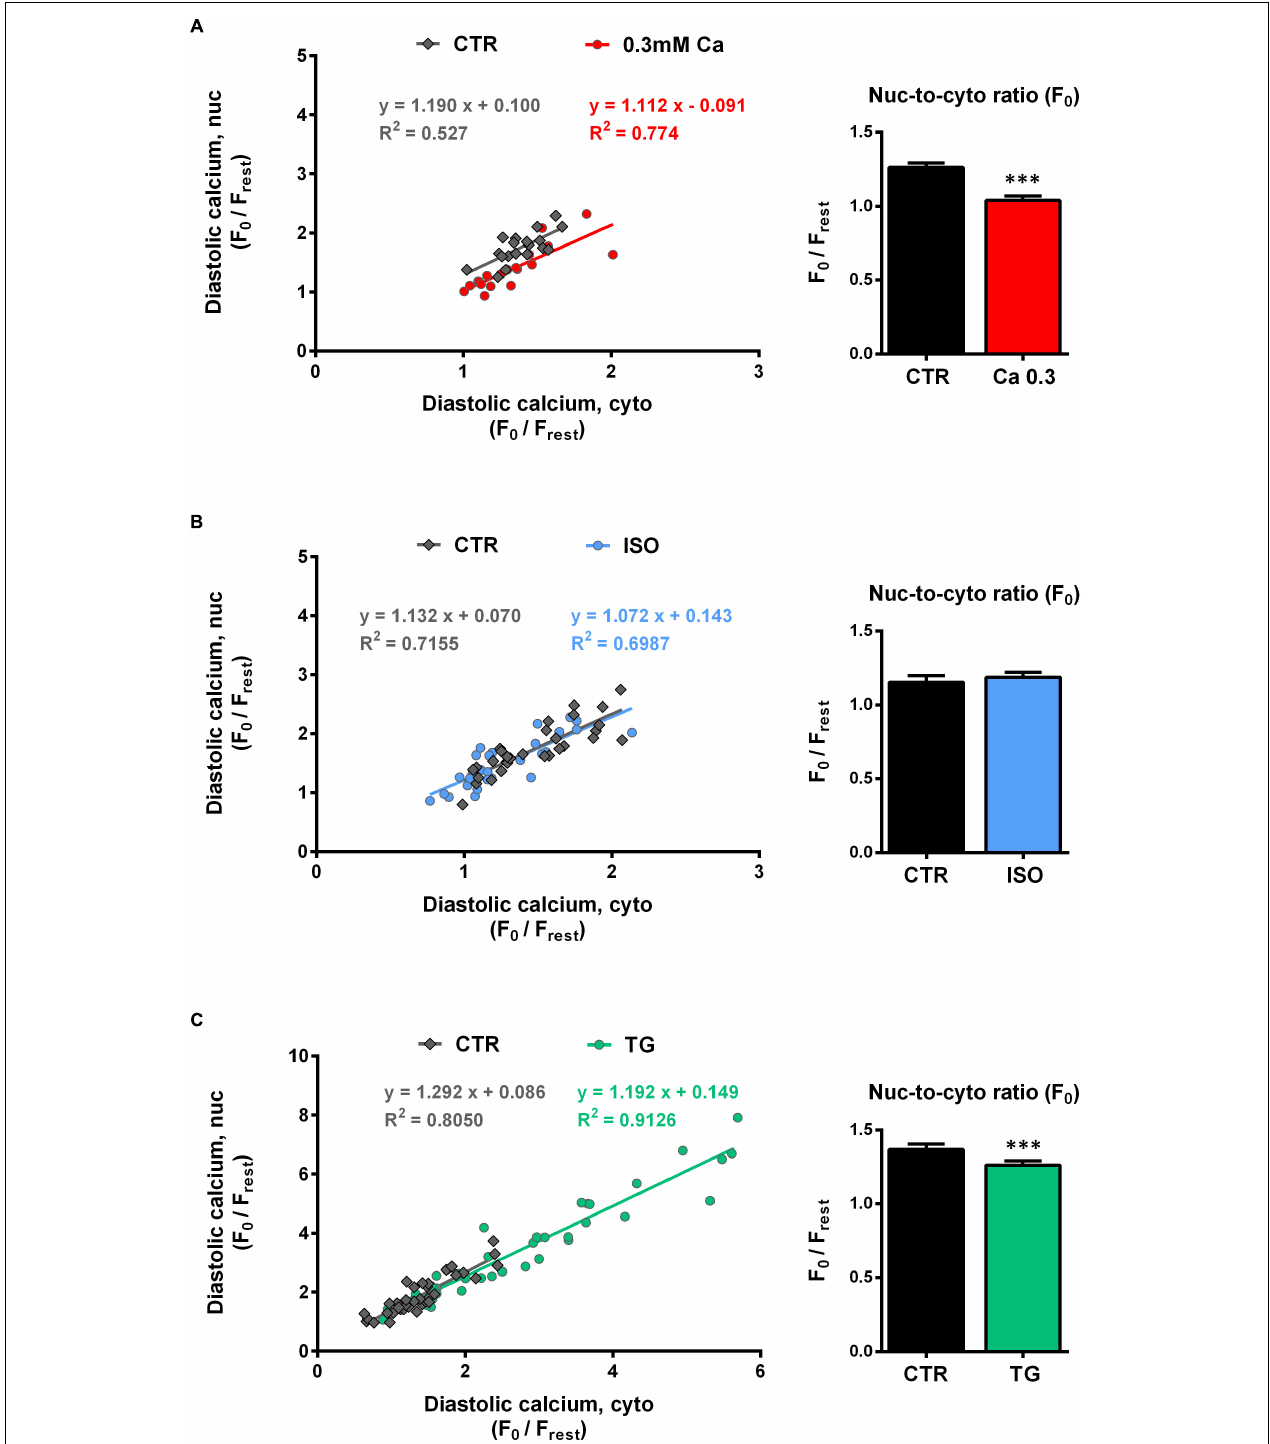
FIGURE 4 | Diastolic nucleoplasmic vs cytoplasmic Ca. [ (A–C) , left panels] Nuclear diastolic Ca as a function of cytoplasmic diastolic Ca. Correlation analysis revealed strong positive correlation for all groups with correlation coefficients r of 0.672 (CTR, 0.3 Ca), 0.853 (0.3 Ca, red), 0.867 (CTR, ISO), 0.824 (ISO, blue), 0.889 (CTR, TG) and 0.956 (TG, green); all P < 0.01. Individual values from the various groups (red = Ca 0.3, blue = ISO, green = TG, black = CTR) were fitted by a linear regression line (as indicated). [ (A–C) , right panels] Average values of nuc-to-cyto ratios (N/C) of the diastolic Ca. Significantly decreased diastolic N/Cs were observed at 0.3 mM Ca (red) and after TG application (green); stimulation with ISO (blue) did not produce any significant changes. ∗∗∗ P < 0.001 vs CTR, Ca 0.3: n / N = 19/7, ISO: n / N = 30/7, TG: n / N = 39/13.